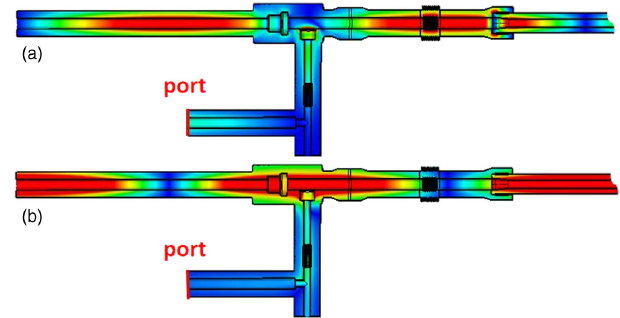
FIG. 7. The antenna is adjacent to the electric field node and the magnetic field antinode, with the field frequency at 162.5 MHz. The left short is at the position of z ¼ − 88 cm. (a) shows the electric field distribution in the cavity; (b) shows the magnetic field in the cavity.